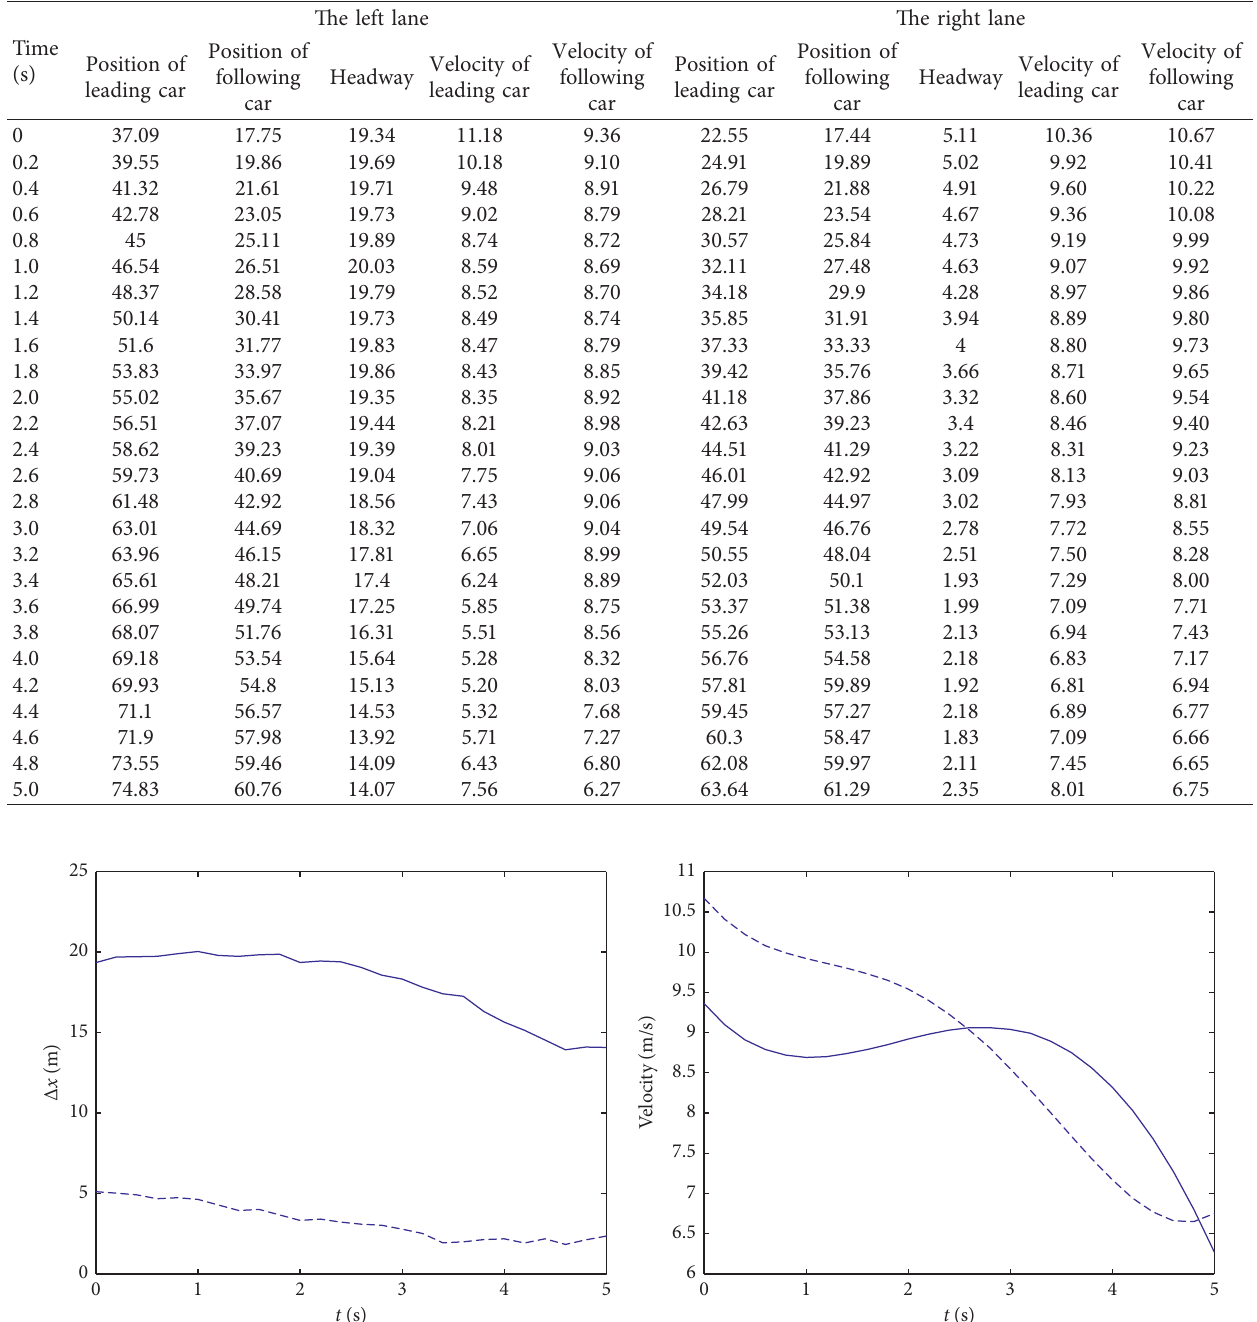
Table 1: Data of the vehicle in Figure 1.